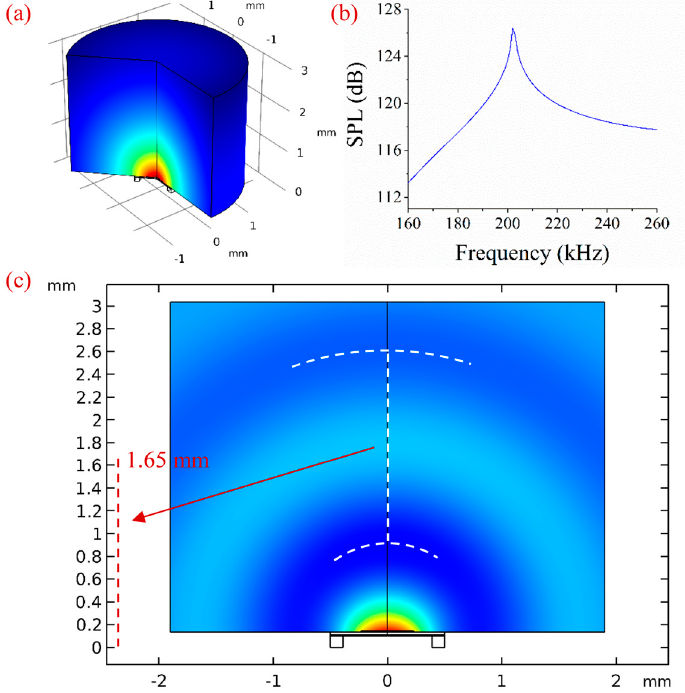
Figure 11. ( a ) The sound pressure level (SPL) in air domain. ( b ) The frequency response curve. ( c ) Simulation of the sound pressure field.